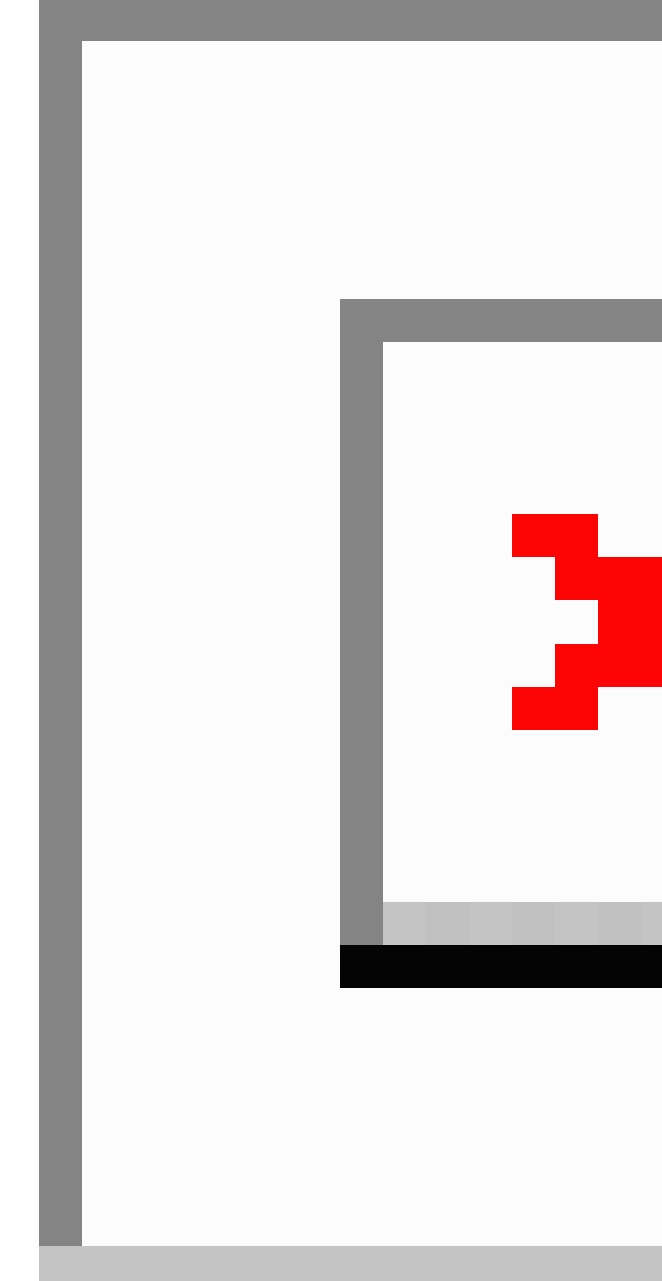
Figure 3. Screening, recruitment process, and random